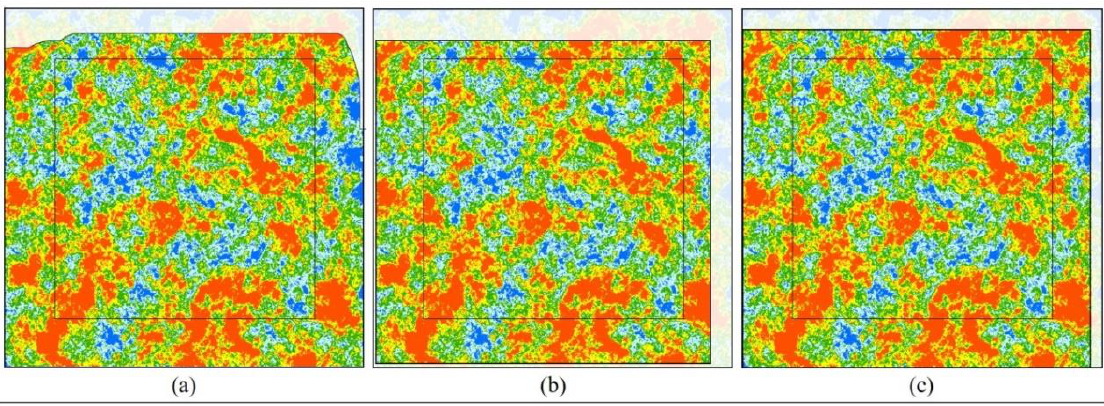
Figure 7. The edge effected region (EER) with reduced fire frequency (RFF; semi-opaque white region) identified by ( a ) moving windows (MWs), ( b ) agglomeration of inner lines (AILs), and ( c ) removal of outer lines (ROLs), superimposed upon the 2900×2900 grid GFF 1200 map. The inner square shows a constant 40 km buffer. Table 1. The maximum (max.) edge width (km), the side of the landscape on which it occurred, and the length-weighted mean edge width of the whole grid-level fire frequency (GFF) map. The 11 GFF N maps differ in number (N) of fire-year maps. The three methods compared are moving windows (MWs), agglomeration of inner lines (AILs), and removal of outer lines (ROLs). GFF N MW max. AIL max. ROL max. Weighted mean edge (km)